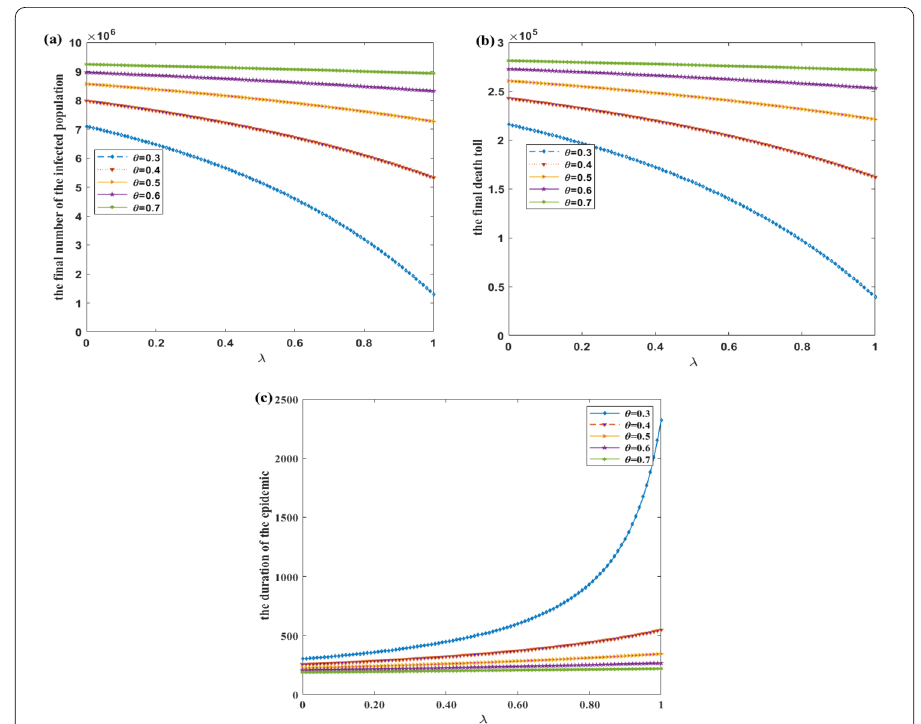
Figure 3 The influences of different proportions of wearing masks in the susceptible and exported populations on the final number of the infected population, the final death toll, and the duration of the epidemic under θ = 0.3,0.4,0.5,0.6,0.7. Vertical axis: ( a ): the final number of the infected population; ( b ): the final death toll; ( c ): the duration of the epidemic. Lateral axis: the proportion λ of wearing masks in the susceptible and exported